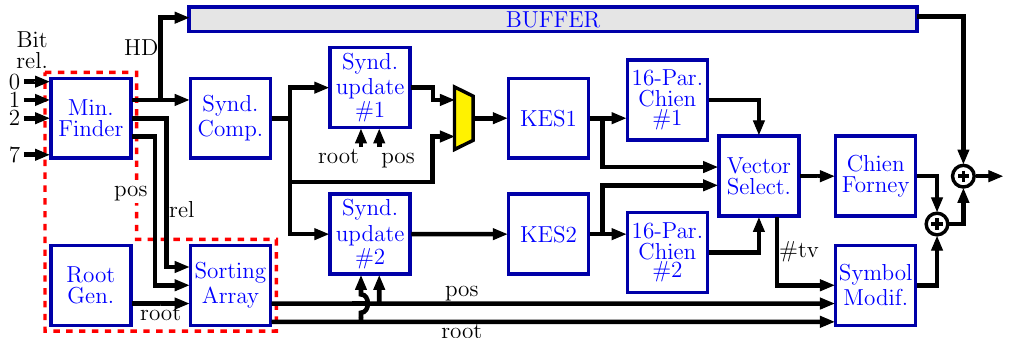
Figure 2. Block diagram for the Q5 decoder.